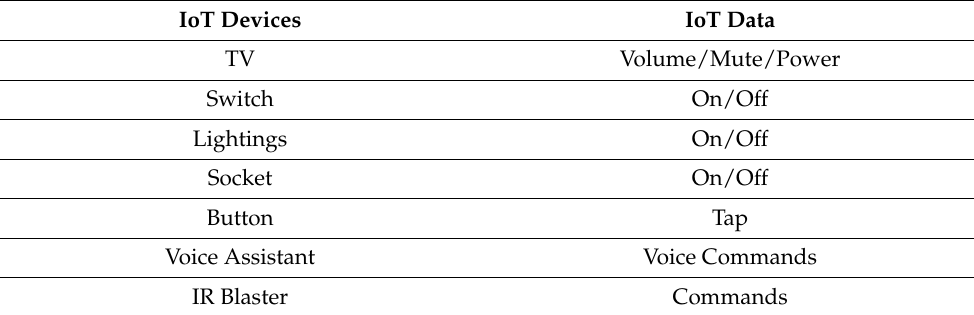
Table 2. IoT devices and their